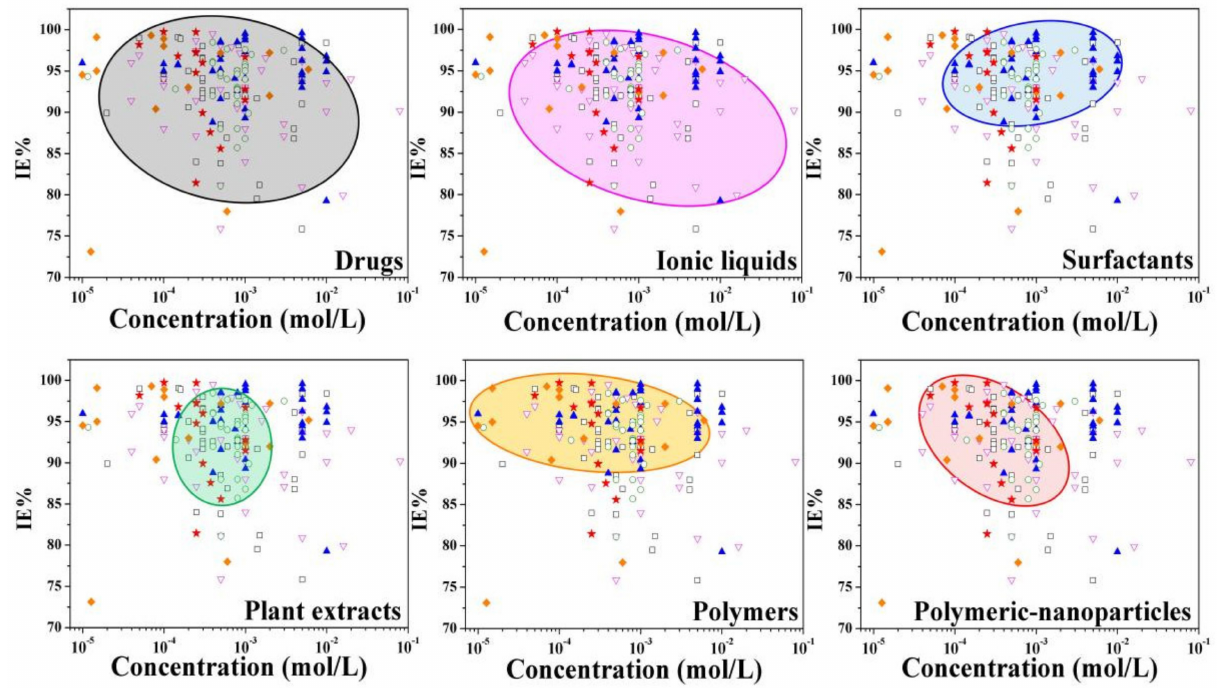
Figure 18. Scatter plot of optimum concentration and the corresponding max inhibition efficiency for six kinds of inhibitors, and their respective the main region of the distribution (the source of the data is in Supplementary Tables S2–S7 where the optimum concentration values are given in moles/millimoles/micromoles per